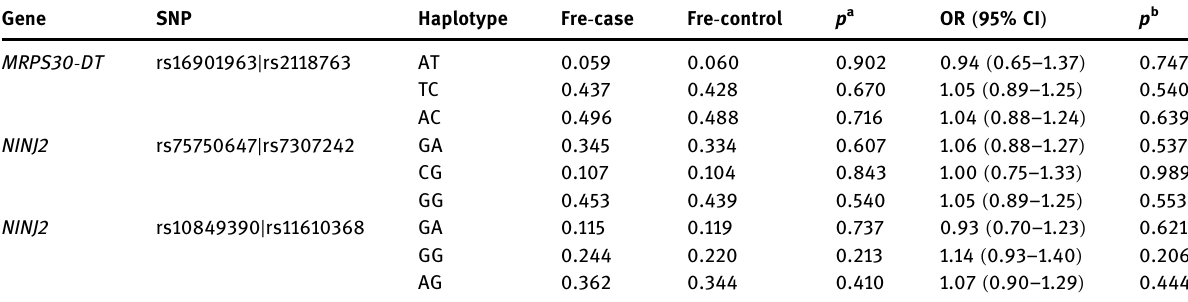
Table 6: Haplotype analysis of the association between MRPS30 - DT and NINJ2 polymorphisms and lung cancer risk Gene SNP Haplotype Fre - case Fre - control MRPS30 - DT